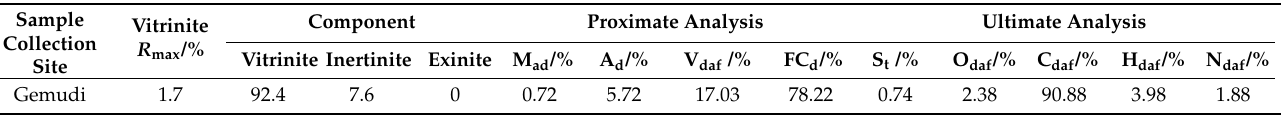
Table 1. Proximate analysis and ultimate analysis of vitrinite in Gemudi.